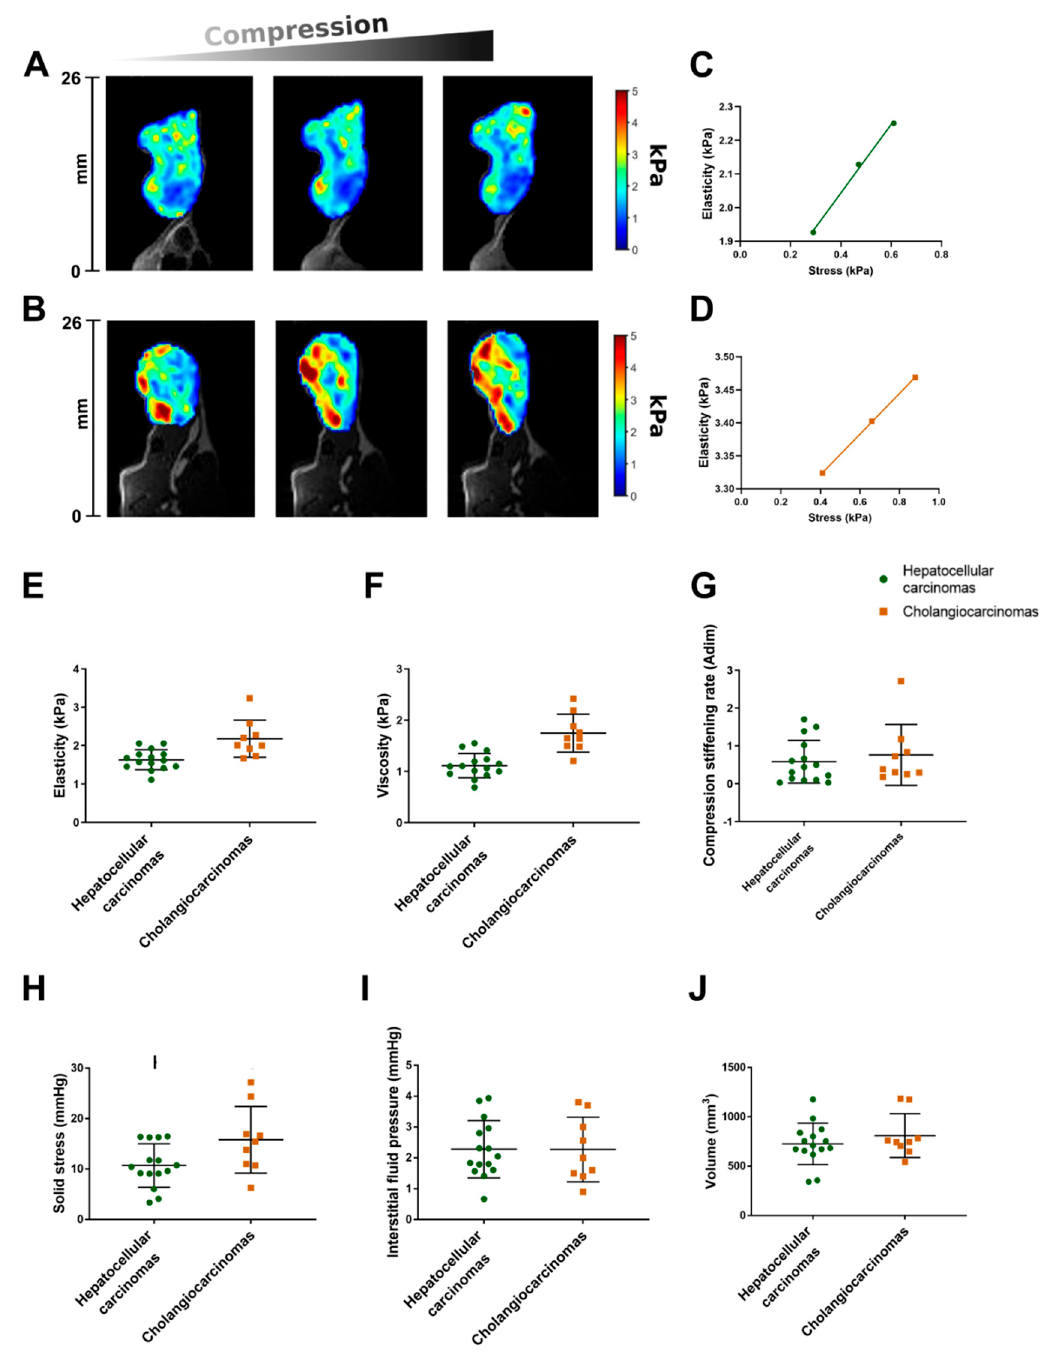
Figure 1. Mechanical properties ( A – F ), pressure measurements ( G , H ), and tumor volume ( I ) in hepatocellular carcinomas and cholangiocarcinomas. Elasticity color maps of hepatocellular carcinoma ( A ) and cholangiocarcinoma ( B ) from basal state (left) to maximum compression (right). Apparent elasticity increases with compression. ( C ) Corresponding compression stiffening rates in the hepatocellular carcinoma (( C ), 1 adim) and the cholangiocarcinoma (( D ), 0.7 adim). Box and scatter plots of mechanical properties show that elasticity and viscosity are significantly lower in hepatocellular carcinomas than in cholangiocarcinomas ( p < 0.001) ( E , F ). Compression stiffening rate does not significantly differ between hepatocellular carcinomas and cholangiocarcinomas ( p = 0.49) ( G ). Solid stress is significantly lower in hepatocellular carcinomas than in cholangiocarcinomas ( p = 0.04) ( H ). Interstitial fluid pressure and tumor volume do not significantly differ between hepatocellular carcinomas and cholangiocarcinomas ( p = 0.77 and p = 0.60, respectively) ( I , J ). Middle horizontal bar on graphs represents median. Lower and upper horizontal bars represent 25th and 75th percentiles.